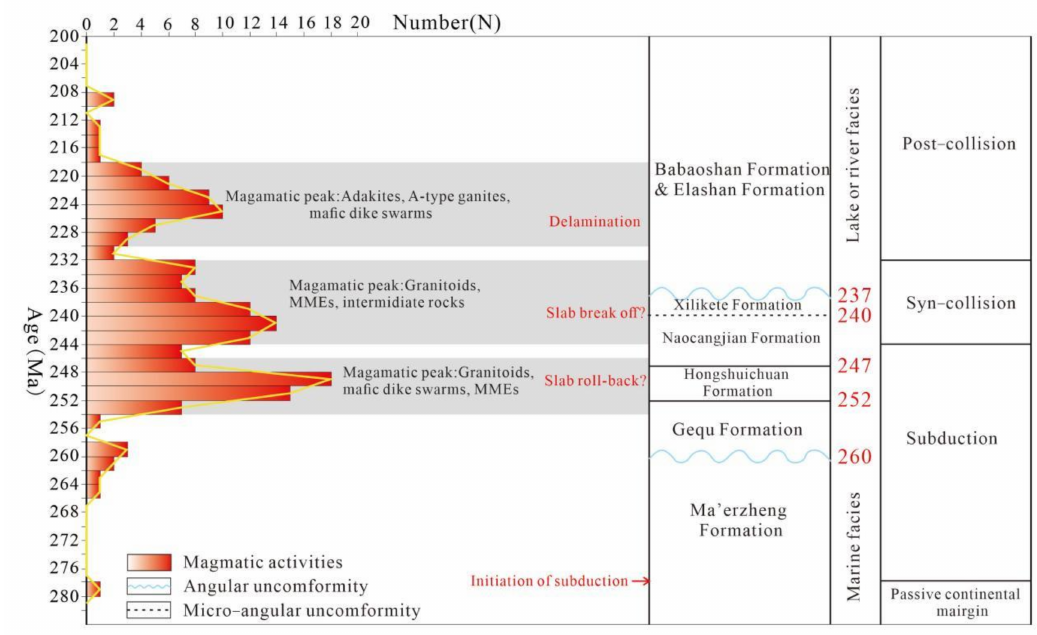
Figure 13. The histograms of ages of the Late Permian-Triassic igneous rocks and strata data in the eastern of the East Kunlun Orogenic Belt. The ages data sources are the same as those in Table S4, and the strata data modified after